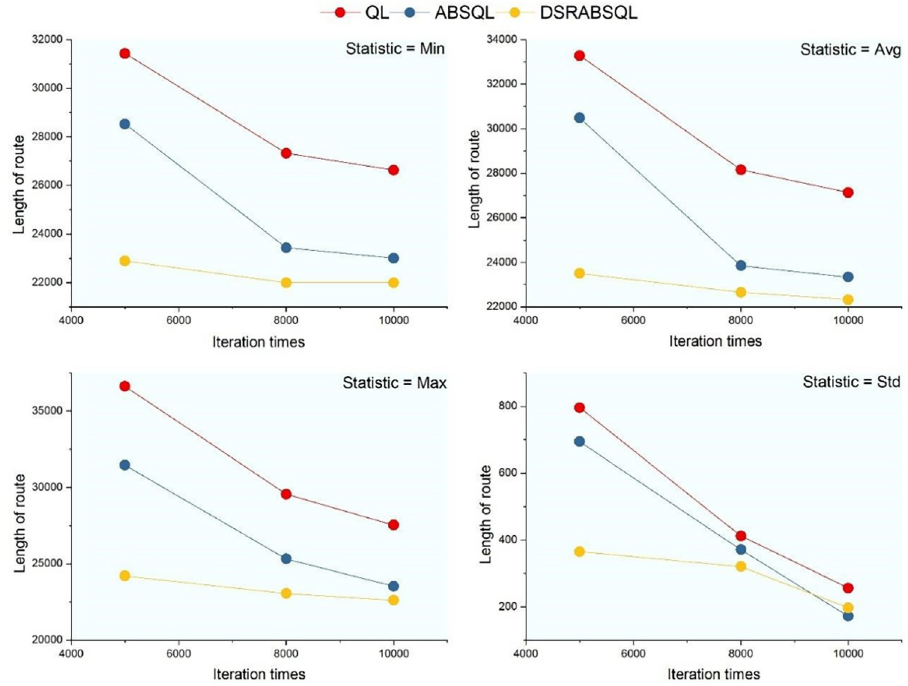
Fig 9. min , avg , max and S td of fl1400 obtained by three algorithms.